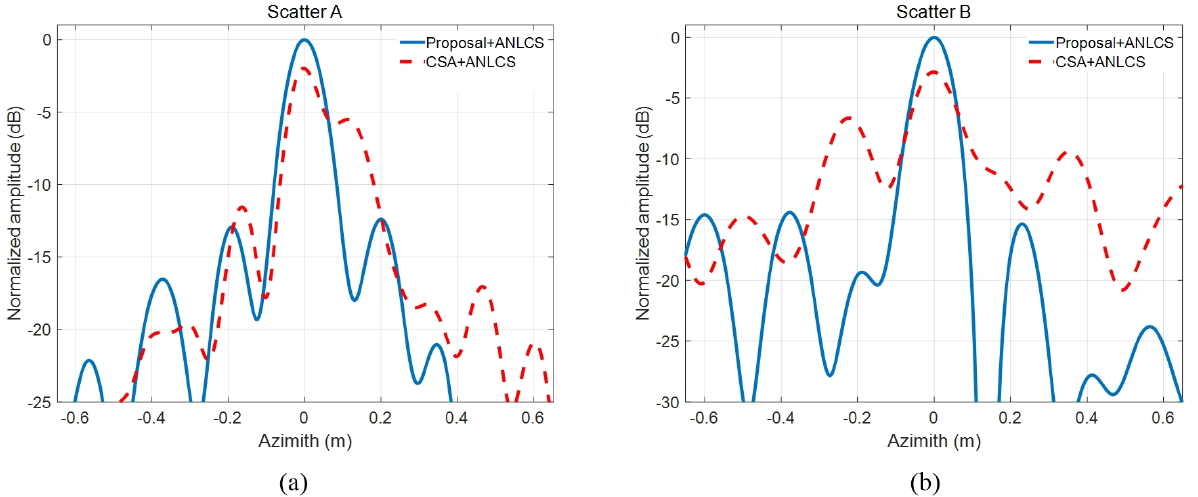
Figure 9. Azimuth impulse response comparisons. ( a ) Scatter A. ( b ) Scatter